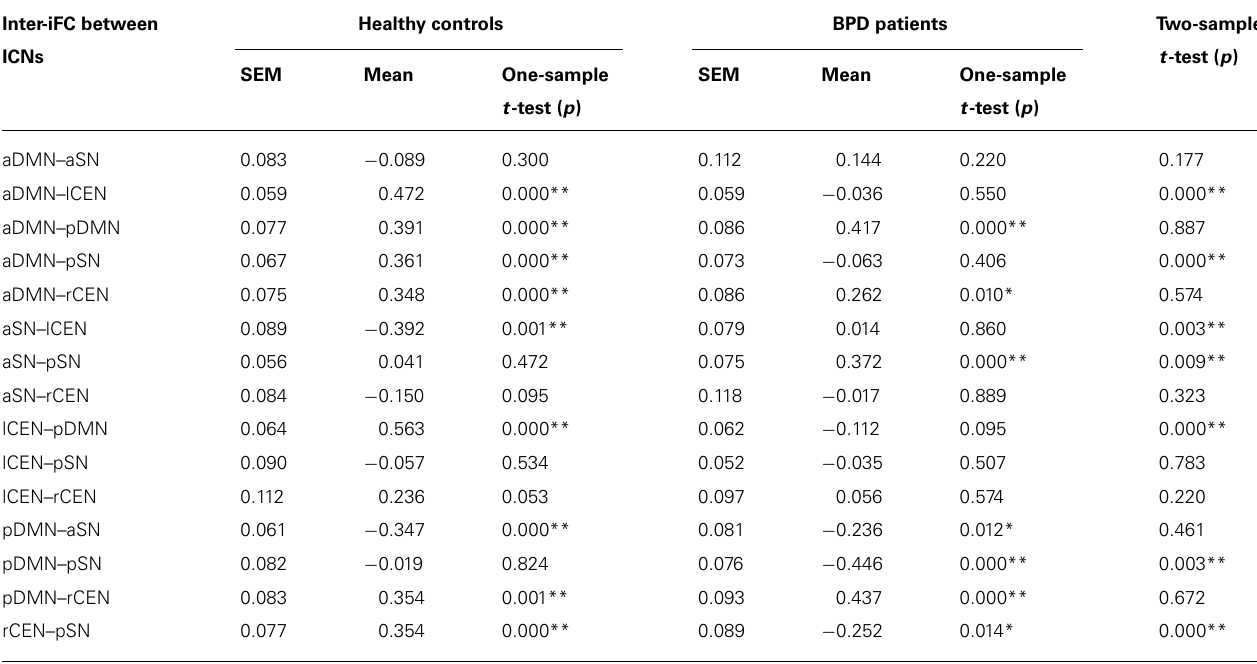
Table 5 | Inter-iFC between DMN, SN, and CEN. Inter-iFC